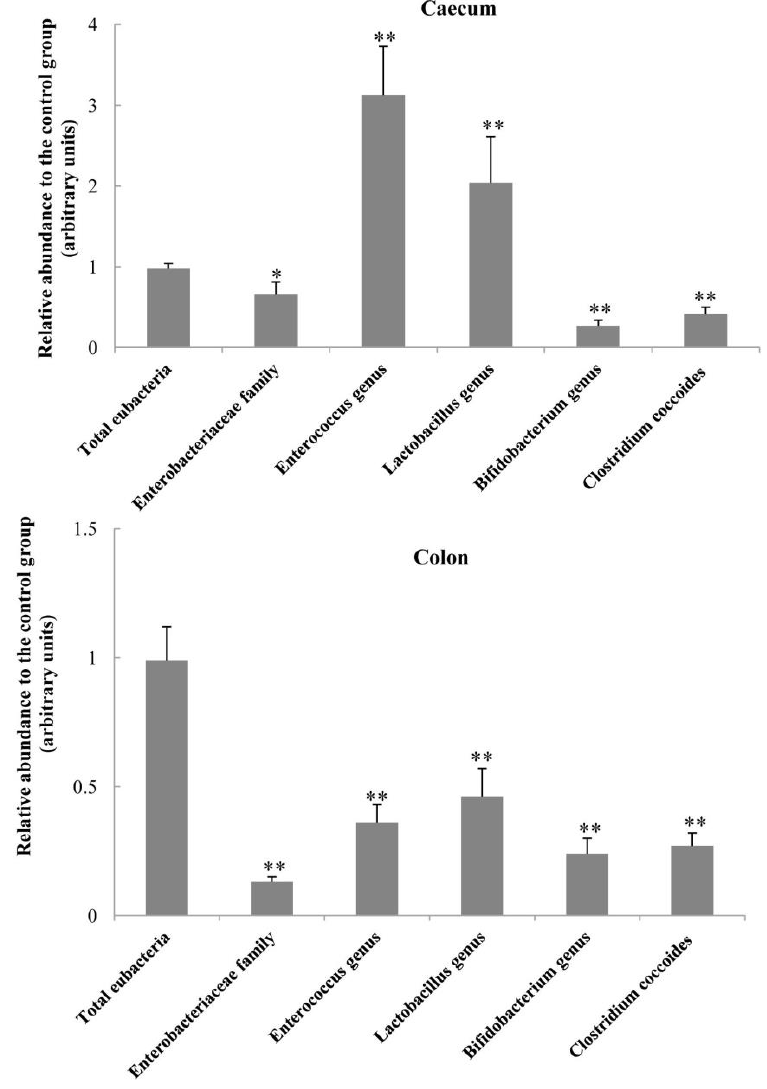
Figure 1. The relative abundance of bacteria in the colon and caecum of piglets. Dietary supplementation with 50 mg/kg oleum cinnamomi (OCM) decreased the abundance of Enterobacterium, Enterococcus , Lactobacillus , Bifidobacterium, and Clostridium in the colon, but increased the abundance of Enterococcus and Lactobacillus in the caecum. DNA levels in the control group were regarded as 1. Data are means ± SD, n = 8. * p < 0.05, ** p < 0.01.